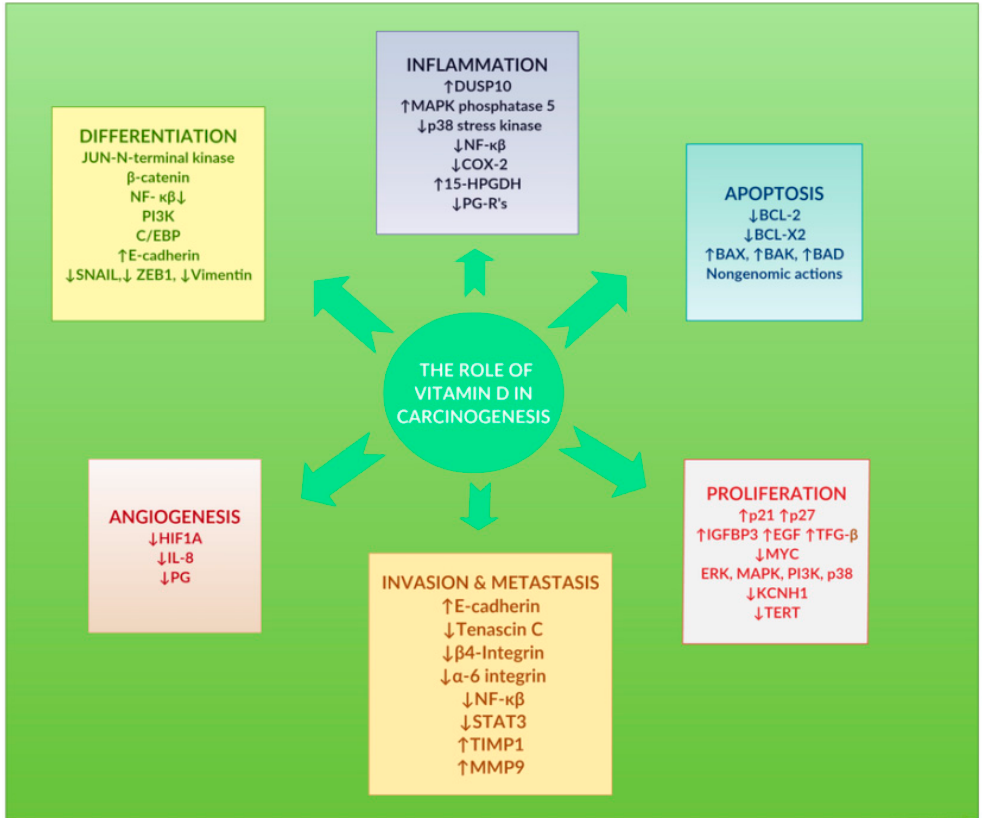
Figure 4. Preclinical basic-sciences studies show that the vitamin D system coordinates vital cellular processes such as cell differentiation, modulation of inflammation, apoptosis, cell proliferation, invasion, and metastatic processes, and angiogenesis. Reproduced with permission from [8], published by Elsevier, 2017.